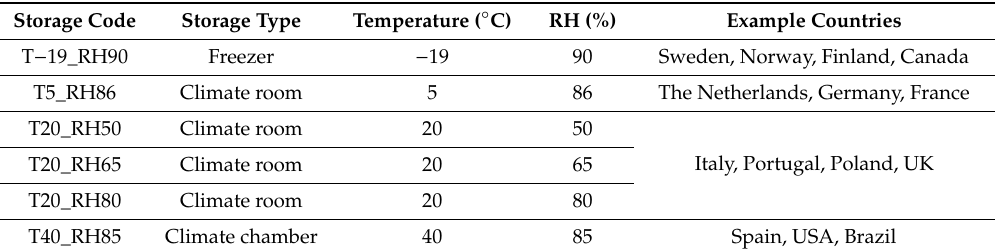
Table 3. Summary of the temperature and relative humidity (RH) of the climate chambers.